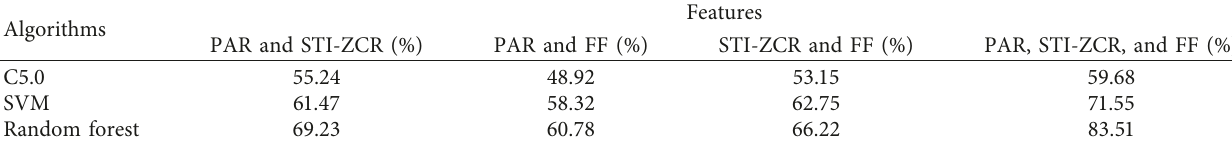
Table 3: Recognition of four microstates with different